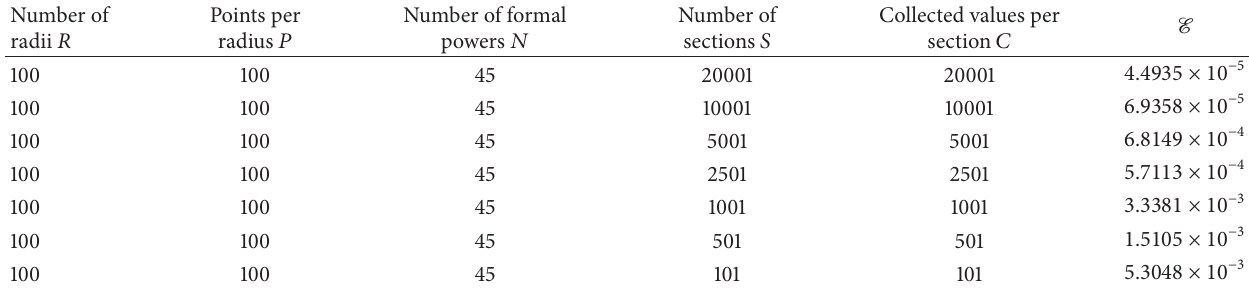
Collected values